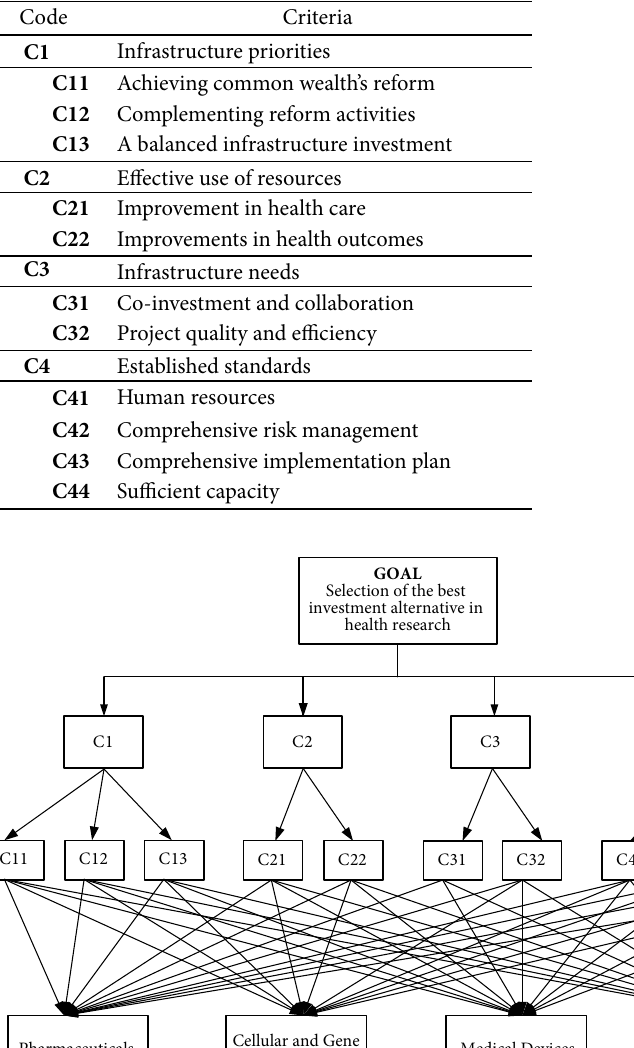
Table 2. Evaluation criteria for investments in health research Code Criteria